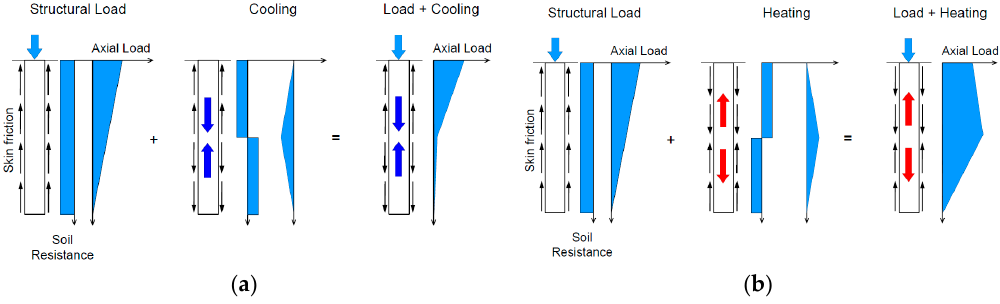
Figure 2. Effect of thermal cycles of the energy piles system on pile stresses [6]. ( a ) Ground cooling reduces stresses along the cross section of the piles which can cause tensile stresses in the piles; ( b ) Heating can cause increased stresses along the cross section of the piles.